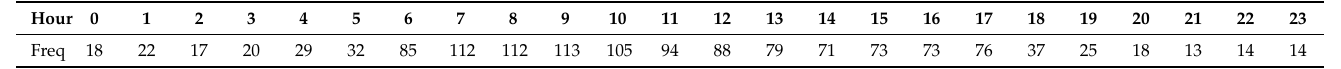
Table 8. Timeslots with high HVAC consumption despite low temperatures.